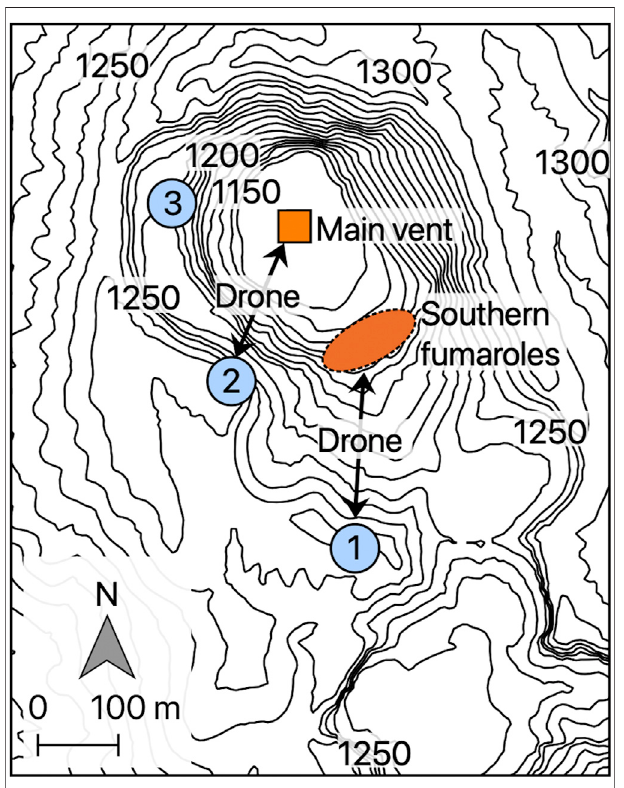
FIGURE 2 | The topographic map of the Nakadake cater, Aso volcano, along with the locations of the large vent at the central part of the crater (main vent) and the active fumarolic area on the southern wall of the crater (southern fumaroles; base map from Geospatial Authority of Japan). The drone with SelPS was operated from an observation deck at the southern rim of the crater (the blue circle numbered 1) during the fi rst four fl ights and from an observationdeckatthesouth-westernrimofthesummitcrater(thebluecircle numbered 2) during the subsequent three fl ights. The location of the western rim of the summit crater where plume samples were collected manually into pre-evacuated fl asks are shown by the blue circle numbered 3.